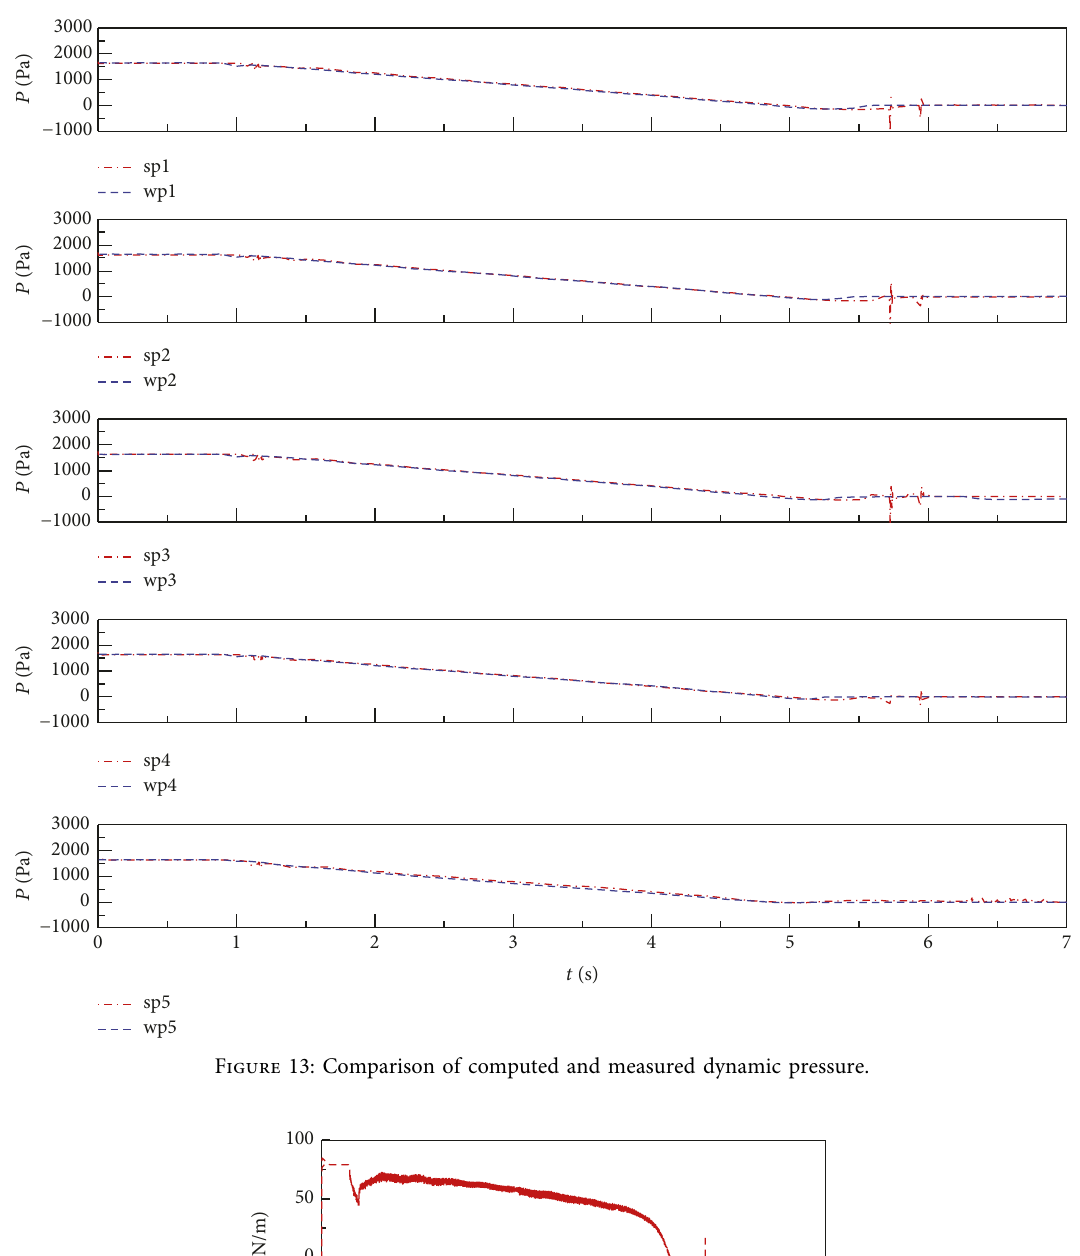
Figure 13: Comparison of computed and measured dynamic pressure.